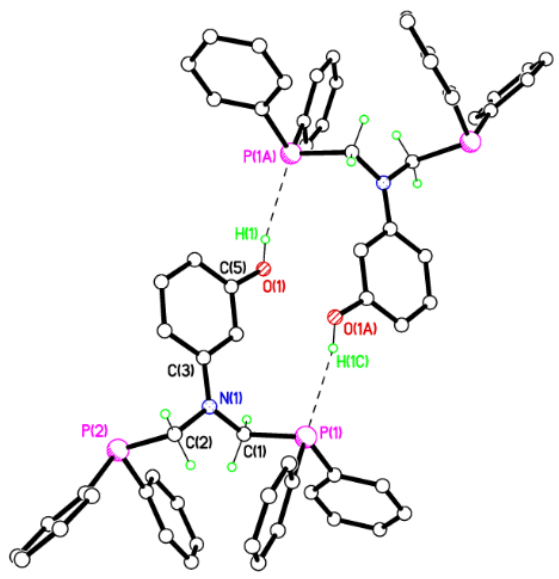
Figure 2. Molecular structure of 3 showing a dimer pair. All hydrogens, except on C(1), C(2) and O(1), have been omitted for clarity. Symmetry code: A = 1 − x, 1 − y, 1 − z.